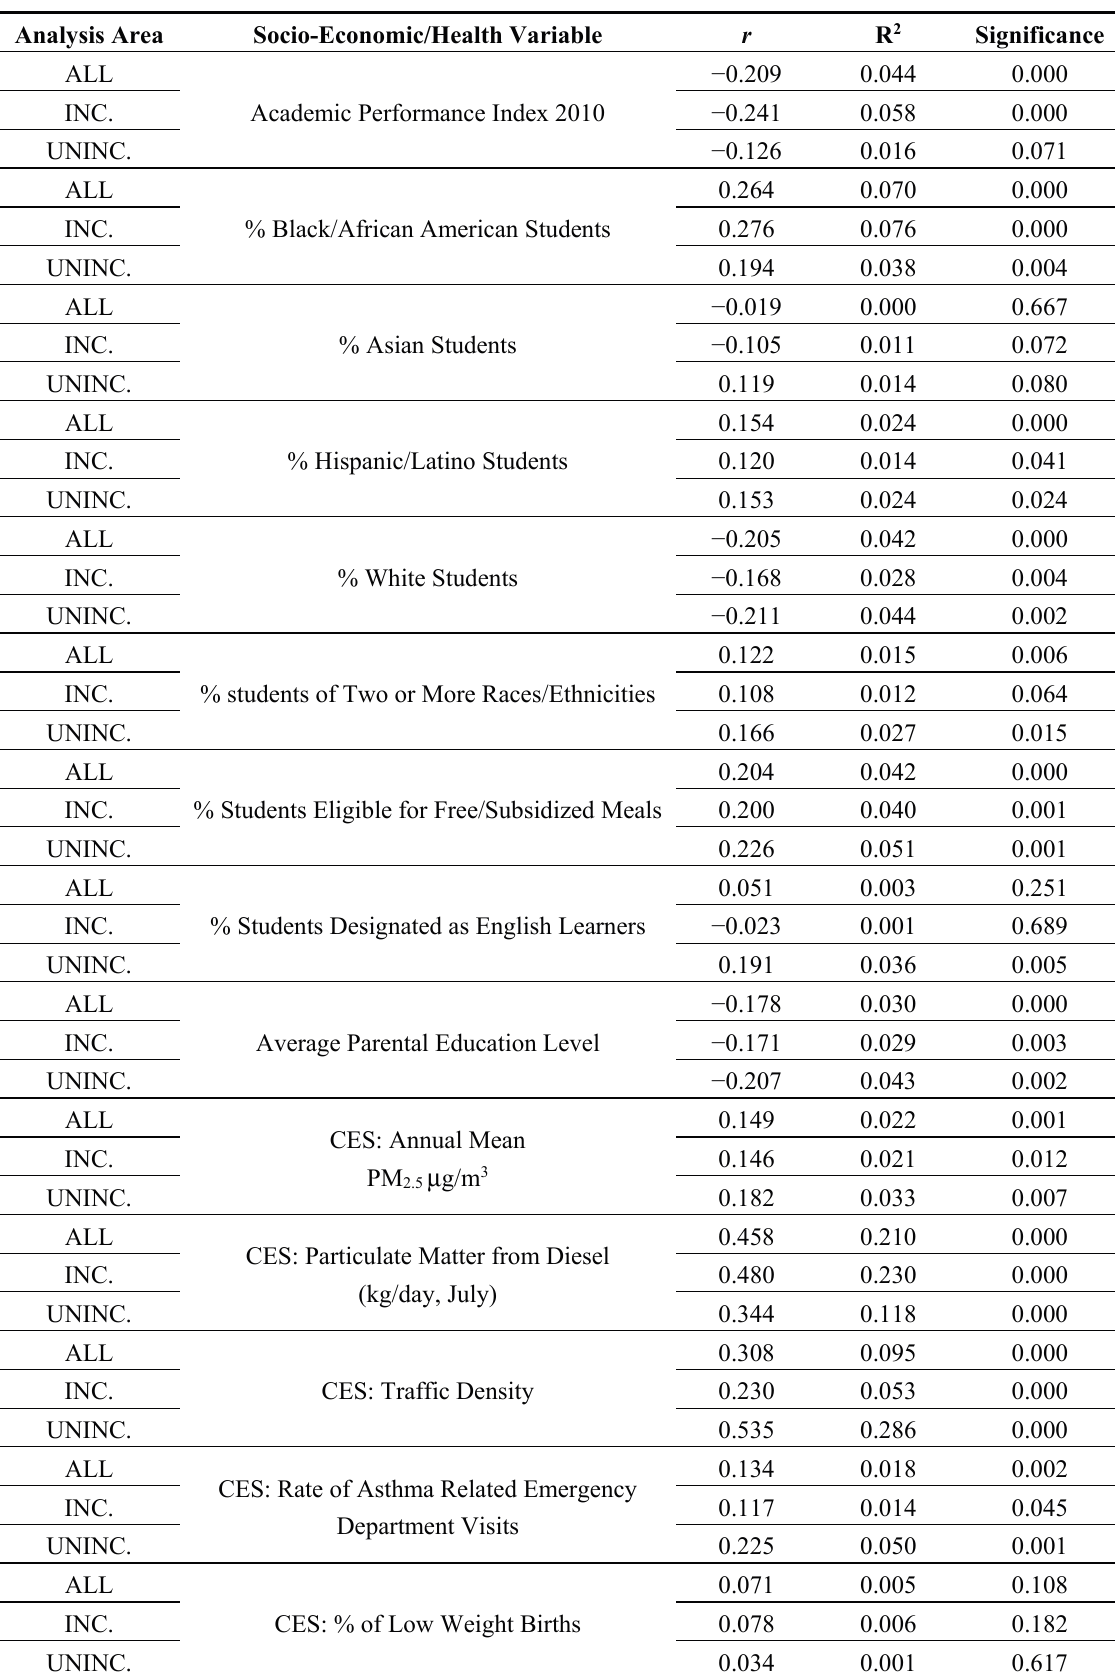
Table 3. Correlation of schools’ PM 2.5 loads with socio-economic and CES variables (significant relationships are shown in bold